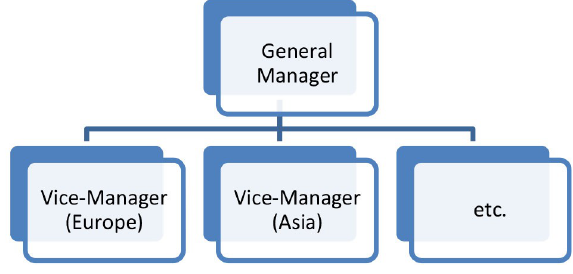
Figure 7. Territory based organizational